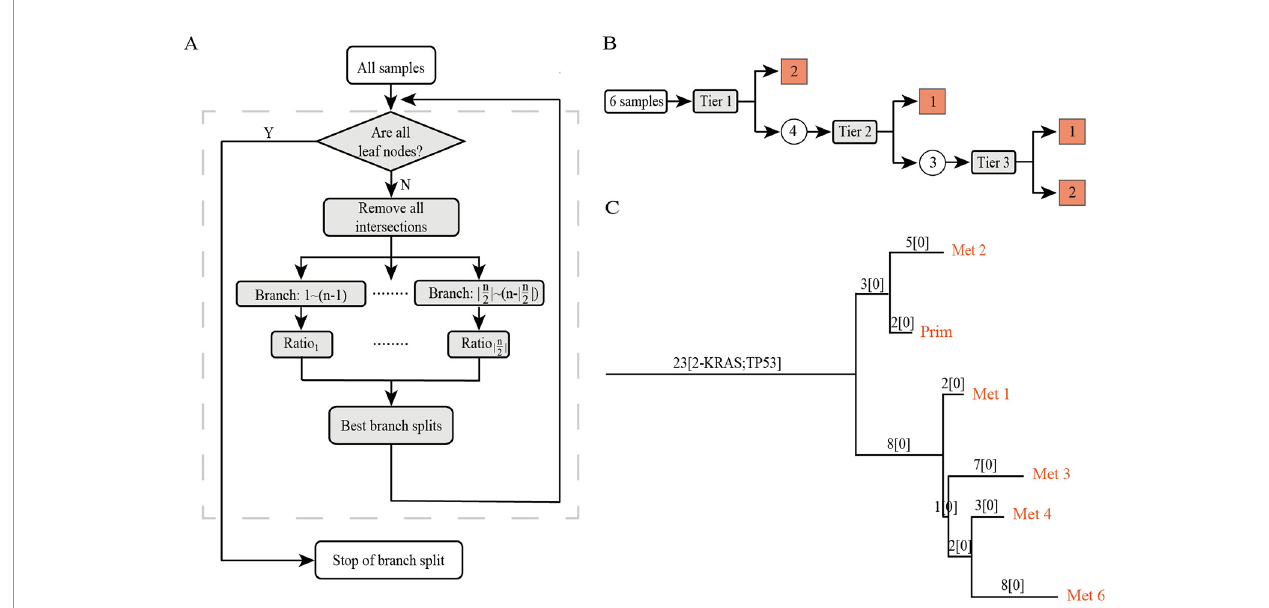
FIGURE 1 | The overview of PTI. (A) The work fl ow of PTI. (B) Taking the patient with six samples as an example, the speci fi c process of PTI inferring the phylogenetic tree is shown in detail. The square grid indicates that the leaf node has been reached, and the circle indicates that the remaining samples still have to be iterated to fi nd the best branch split. (C) An example of a phylogenetic tree inferred by PTI. The phylogenetic tree is a rooted tree whose leaf nodes are samples. The annotation information on the branches includes the length of the branches, which is equal to the number of shared mutations, and the annotation of driver